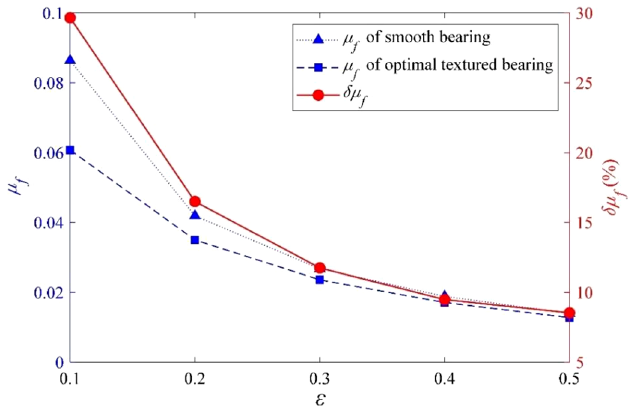
Fig. 15. m f and dm f under e =0.1 – 0.5, ’ = 0, N =3000 rpm.